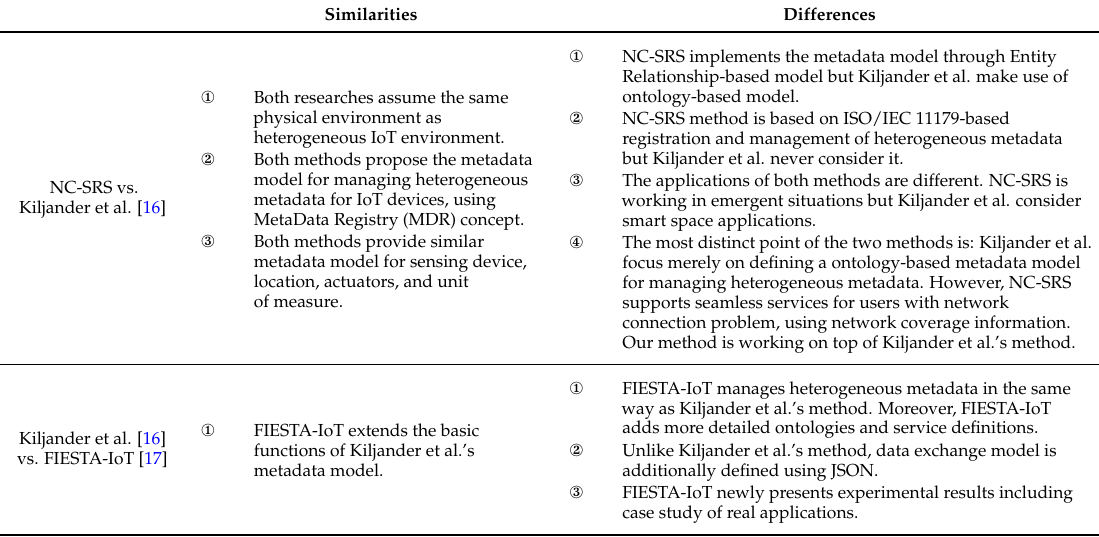
Table 2. Comparison of NC-SRS with the existing methods